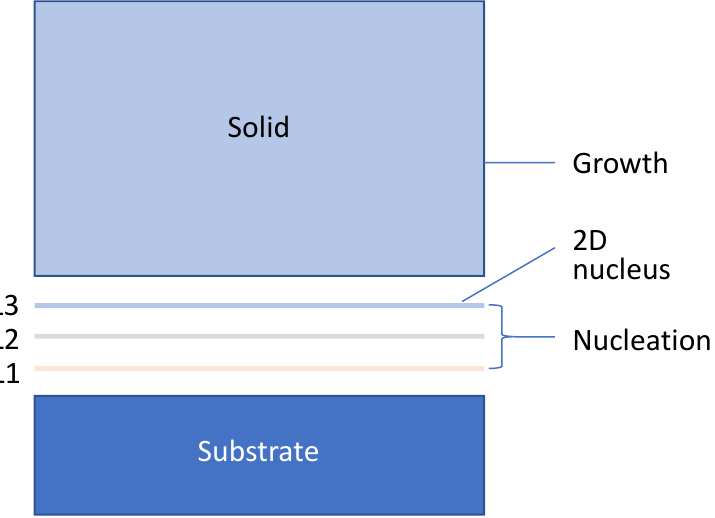
Figure 3. Schematic illustration of the three-layer nucleation mechanism. At the nucleation temperature, heterogeneous nucleation starts with a precursor created by prenucleation, proceeds layer-by-layer through a structural templating mechanism, and completes within three atomic layers (marked as L1, L2 and L3) to provide a 2D nucleus (a crystal plane of the solid) which can template further growth of the solid.